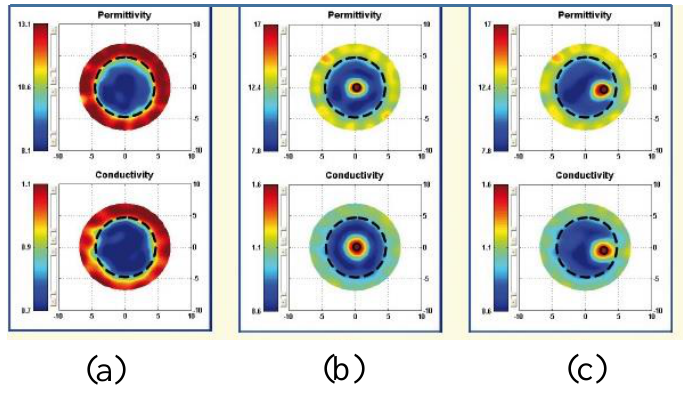
Figure 9. Reconstructed images at 1700 MHz for a breast phantom with a cylindrical 10 mm tumour. ( a ) Image of the breast without a tumour. ( b ) Image of the breast with a tumour positioned at the centre of the breast. ( c ) Image of the breast with a tumour positioned 30 mm right of centre. Marked big circles show the boundaries of the breast [68].